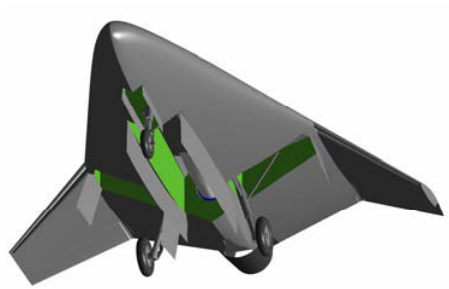
Fig 28. Payload containers opened in flight – both covers are deflected down